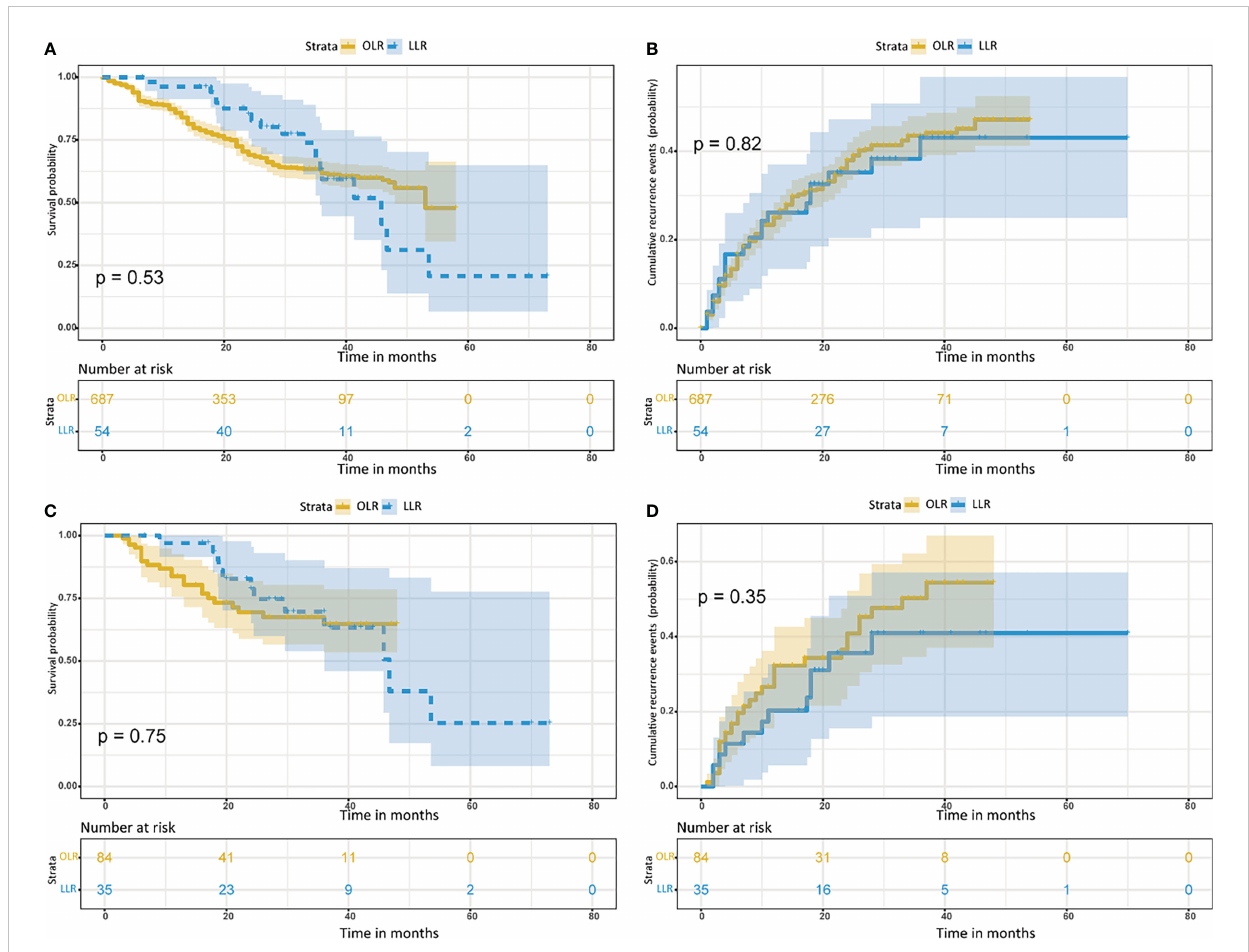
FIGURE 2 Kaplan – Meier curves for patients with hepatocellular carcinoma tumors more than 5 cm and located in the dif fi cult segment after laparoscopic or open liver resection. (A) Overall survival curves and (B) cumulative recurrence curves before propensity score matching. (C) Overall survival curves and (D) cumulative recurrence curves after propensity score matching. LLR, laparoscopic liver resection; OLR, open liver